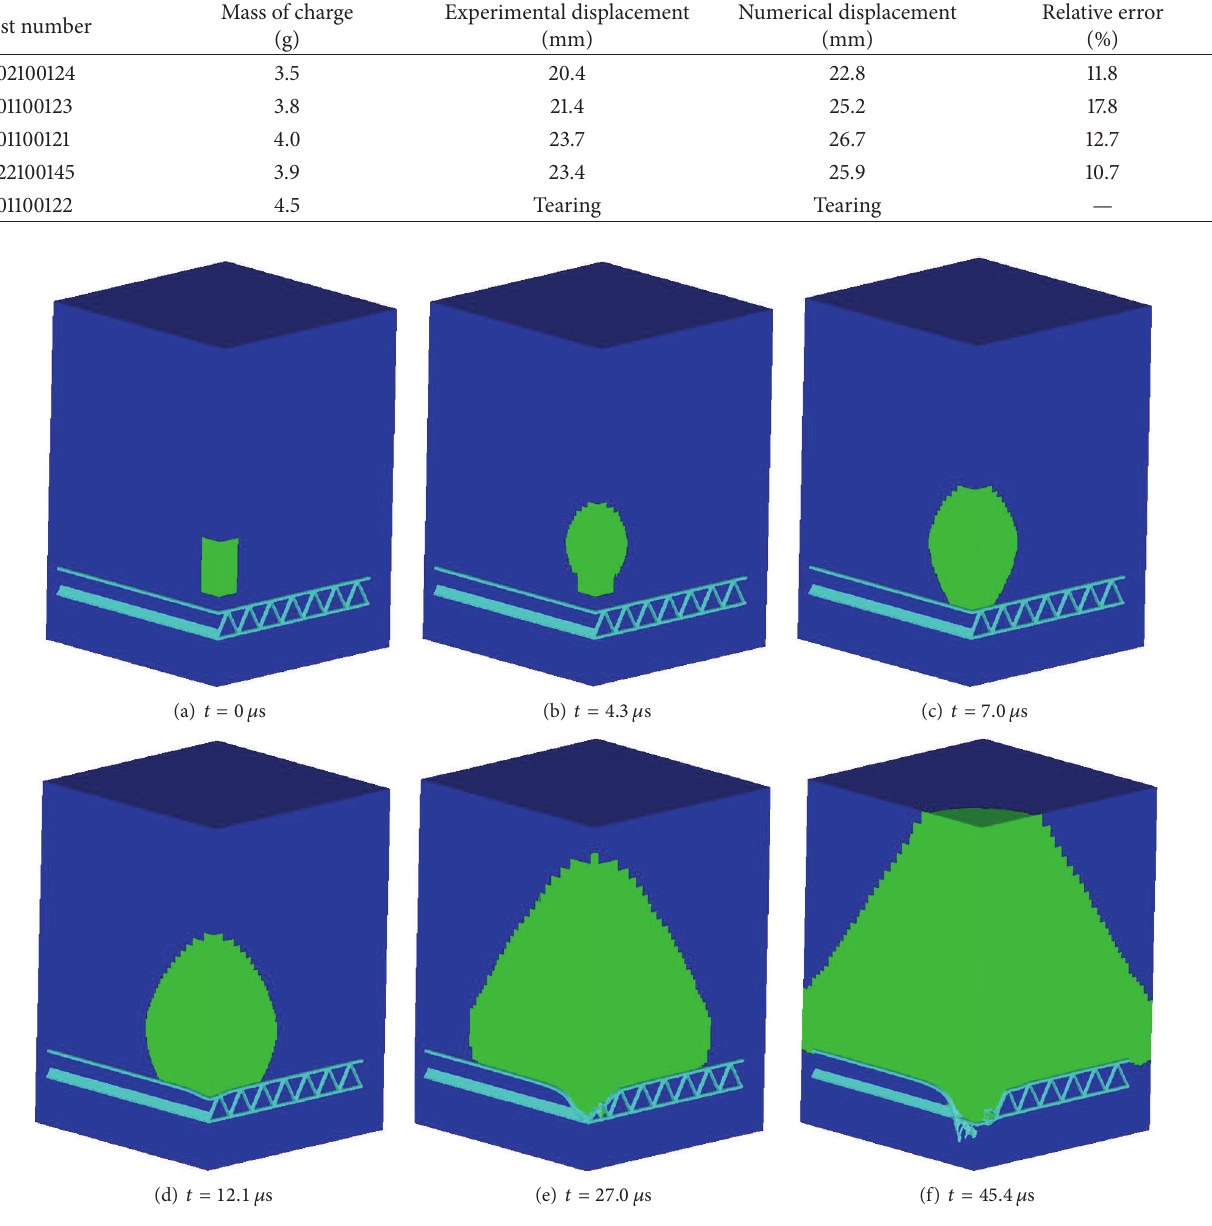
Figure 7: AUTODYN screenshots showing the transient response of the detonation products and the sandwich panel (case number S20-1).